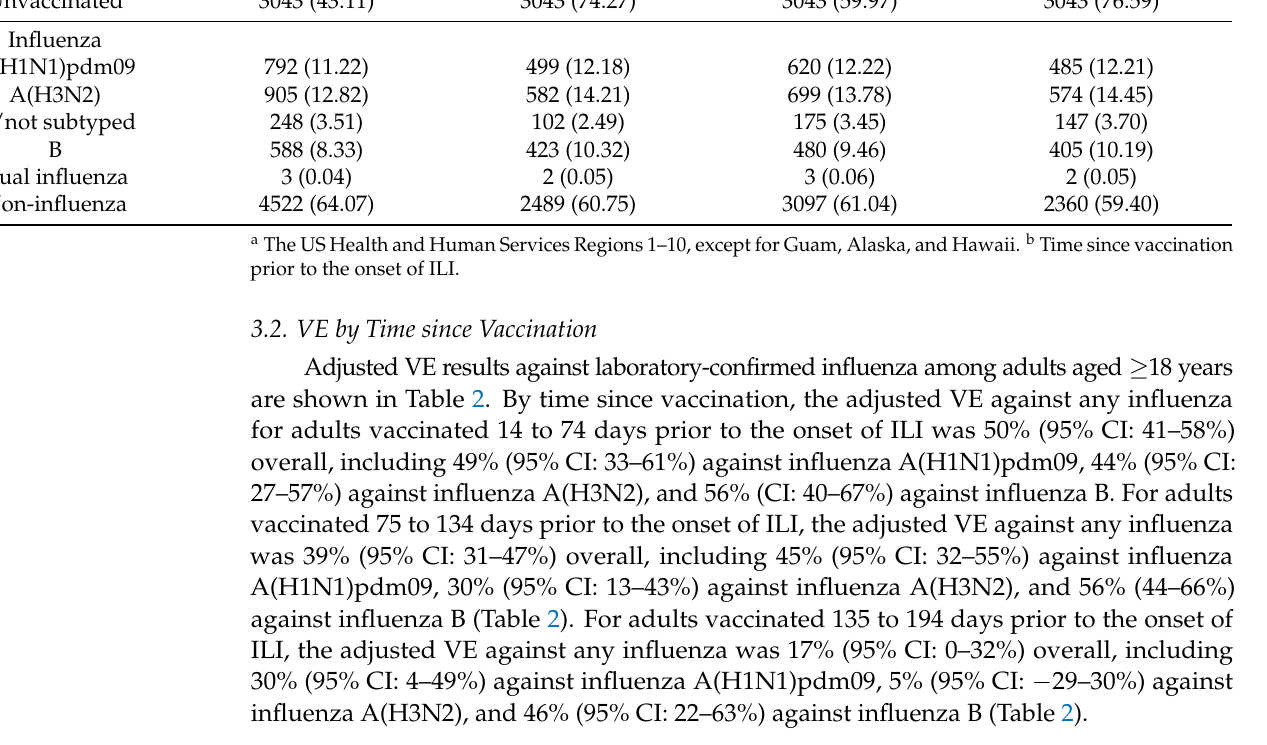
Table 2. Adjusted vaccine effectiveness in adults aged ≥ 18